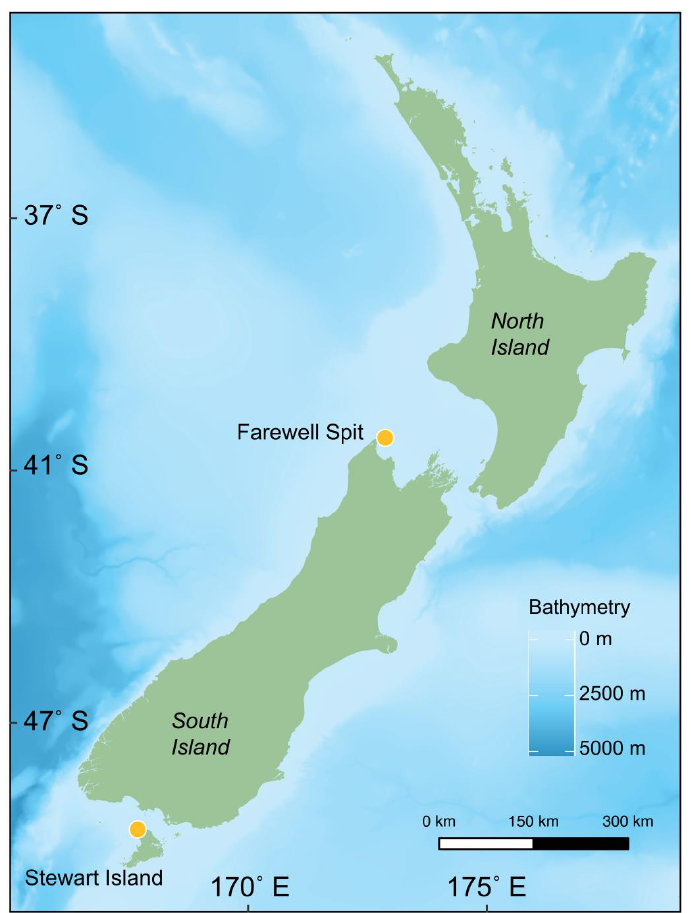
Figure 1. Location of sampling sites of long-finned pilot whale ( Globicephala melas edwardii ) carcasses from mass-stranding events at Farewell Spit and Stewart Island, Aotearoa New Zealand. Bathymetry is depicted with darker shades of blue representing deeper waters (reprinted with permission from National Institute of Water and Atmospheric Research (NIWA) under a Creative Commons BY license, with permission from NIWA original copyright